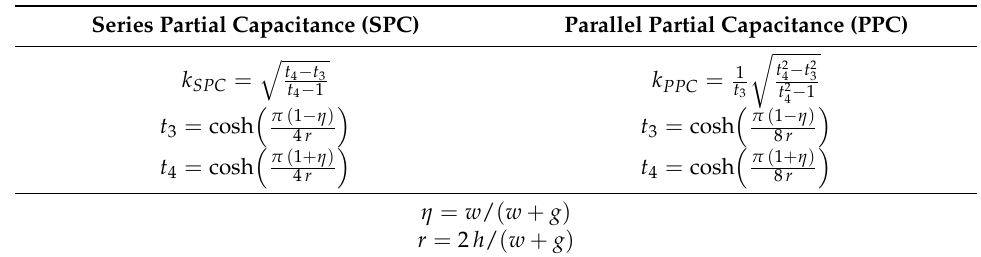
Table 1. Conformal mapping parameters